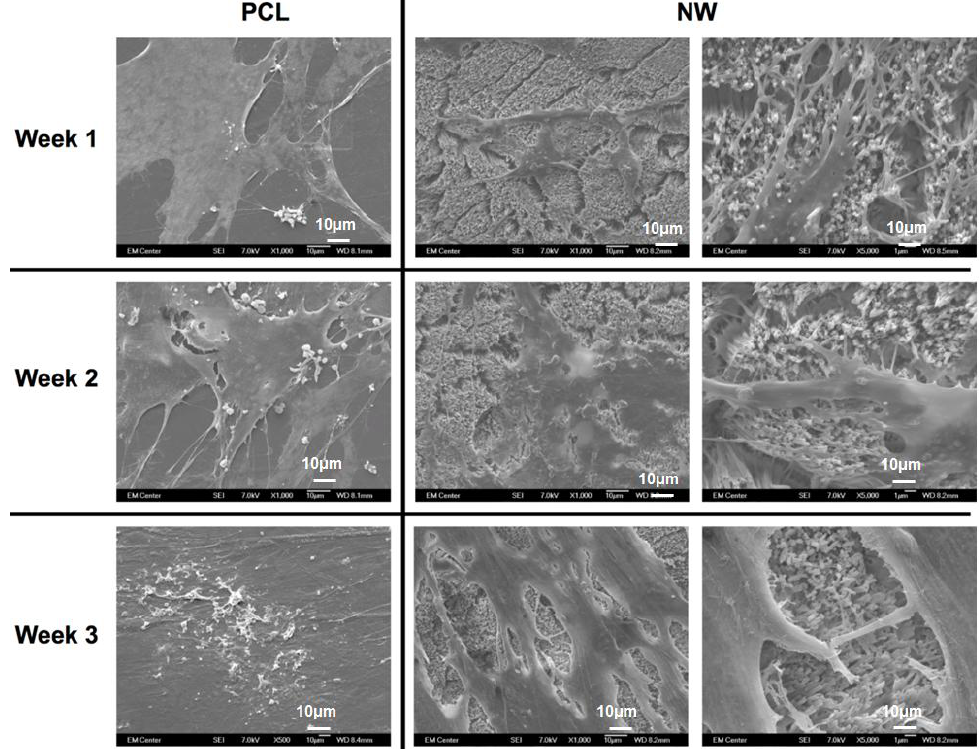
Figure 10. Representative SEM images of ADSCs on PCL and NW after 1, 2, and 3 weeks of culture in chondrogenic